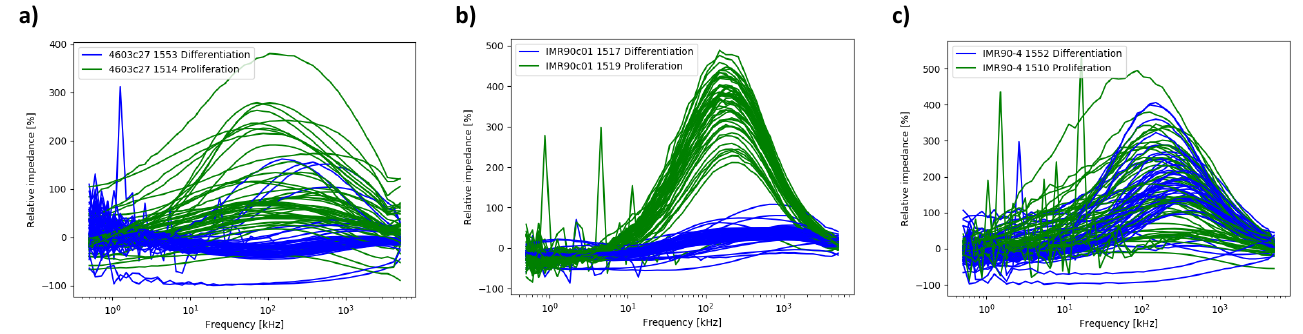
Figure 1: Relative impedance spectra for the three cell lines for proliferation (green) and differentiation (blue) on Day